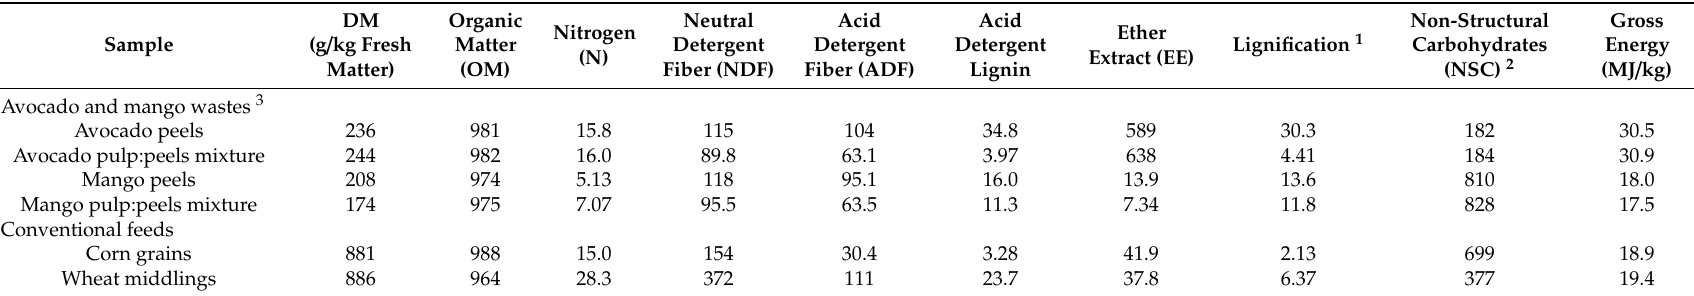
Table 2. Chemical composition (g / kg dry matter (DM) unless otherwise stated) of the avocado and mango wastes, and conventional feeds tested in Experiment 1.